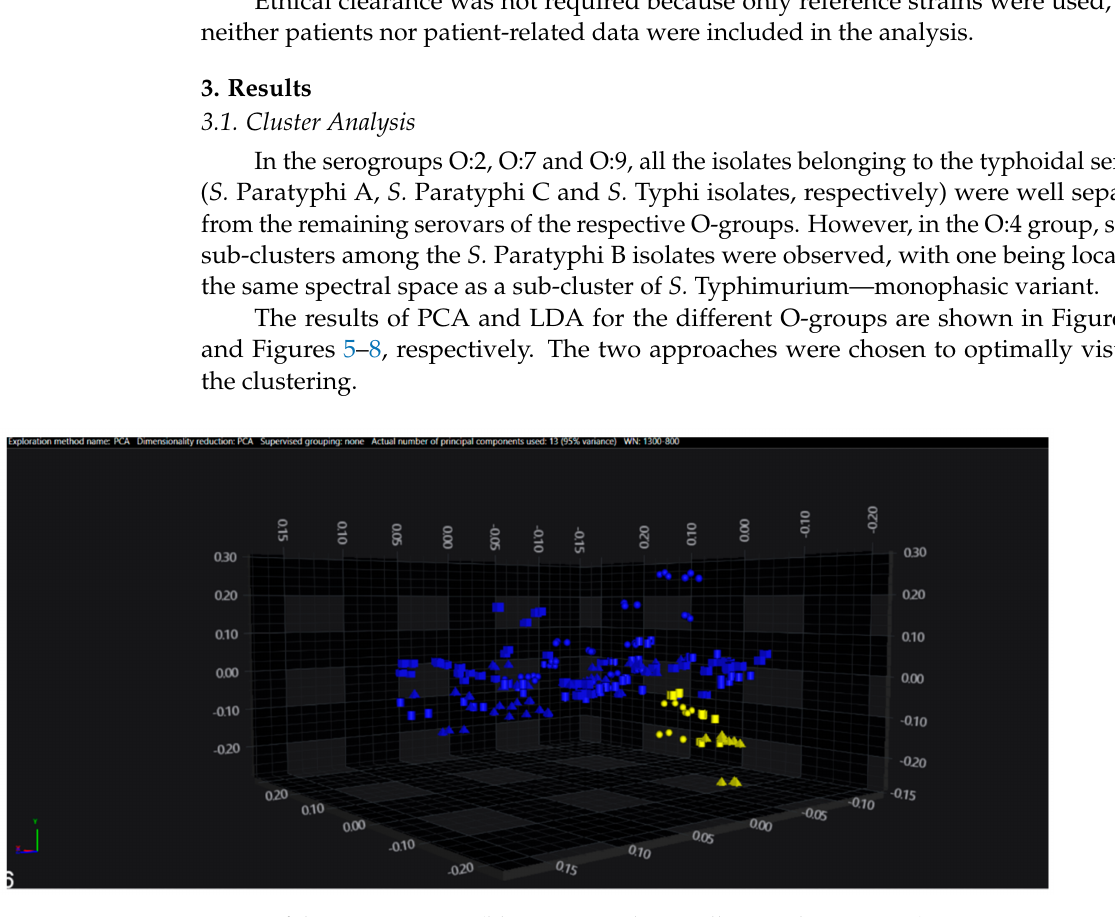
Figure 1. PCA of the O:2 serogroup (blue = Paratyphi A, yellow = other serovars) .